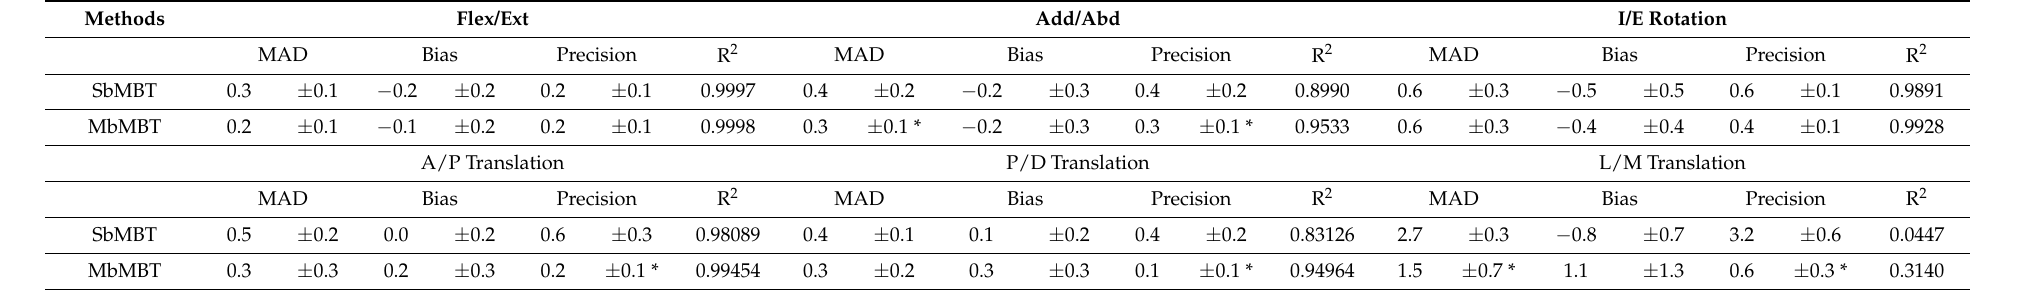
Table 2. The means ± standard deviations of the mean absolute differences (MAD), bias and precision values over all subjects for six degree-of-freedom kinematics of the knee joint during lunge activity. The coefficient of determination values (R 2 ) were obtained from linear regression analysis on the knee kinematics derived from the SbMBT and MbMBT methods against the reference values. Asterisks indicate significant differences in the variables between the MbMBT and